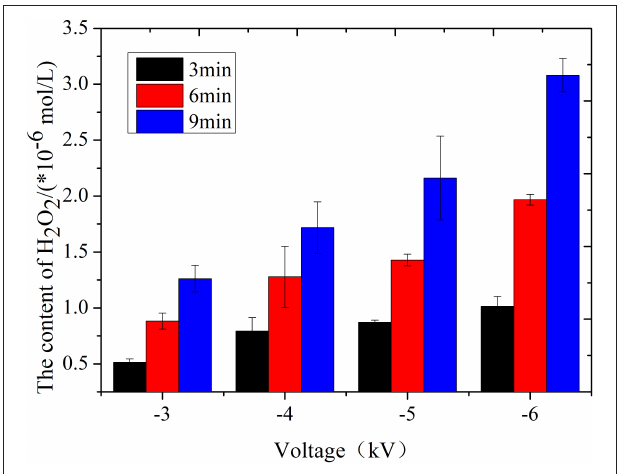
FIGURE 9 | Effect of the treatment time of the air-water jet on the content of H 2 O 2 at four applied